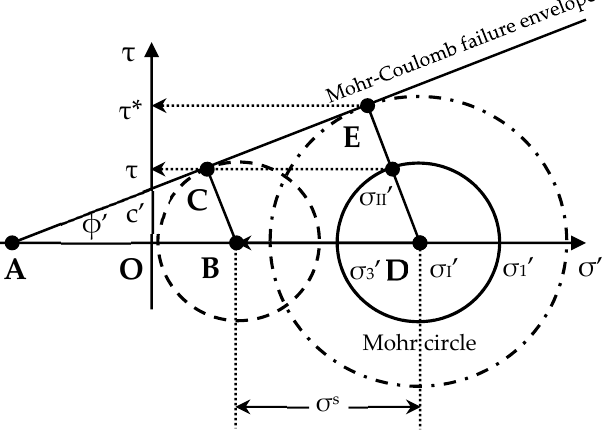
Figure 2. Illustration of the concept of the Mohr circle to obtain a scalar field of the local factor of safety (LFS) (from Lu et al. [30]).